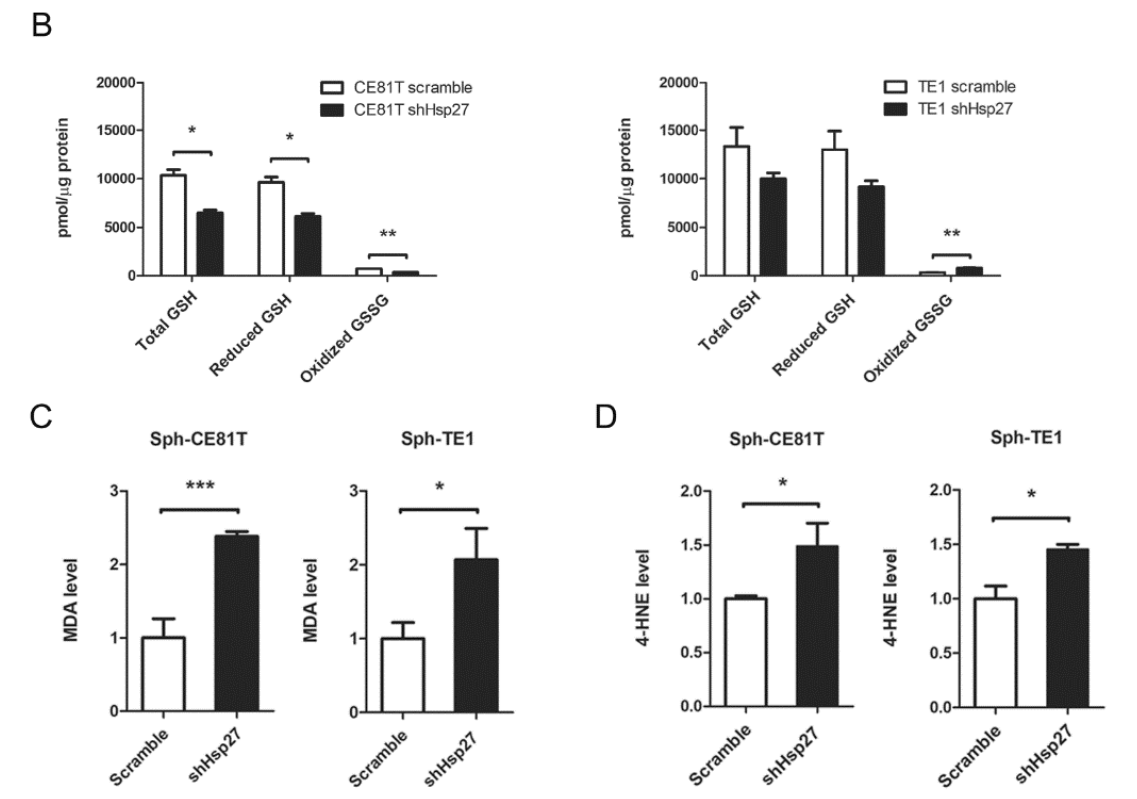
Figure 4. Knockdown of Hsp27 in esophageal cancer cells in spheroid culture induced more lipid peroxidation. ( A ) Left panel, Western blot analysis with quantification of Hsp27, phospho-Hsp27, p53, xCT, and GPX4 of CE81T and TE1 cells in spheroid and adherent culture. Right panel, Western blot analysis with quantification of Hsp27, phospho-Hsp27, p53, xCT, and GPX4 of CE81T and TE1 cells with Hsp27 knockdown (shHsp27) in spheroid culture. Scr, scramble. ( B ) Glutathione meas- urement of TE1 and CE81T cells with Hsp27 knockdown in spheroid culture. ( C ) MDA production of TE1 and CE81T cells with Hsp27 knockdown in spheroid culture. ( D ) 4-HNE of TE1 and CE81T cells with Hsp27 knockdown in spheroid culture. * p < 0.05, ** p < 0.01, *** p < 0.001. p value of B was calculated by two-way ANOVA. p value of C and D were calculated by Student’s t -test.